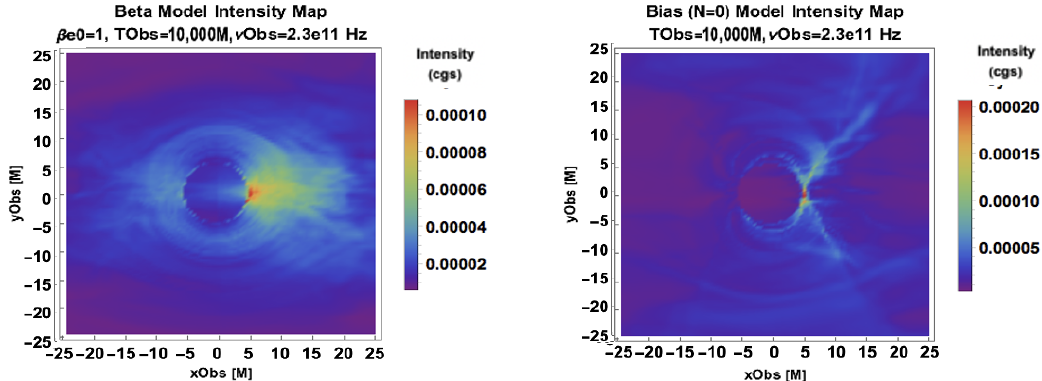
Figure 3. A parameter scan of the Constant Electron Beta Model ( Left ) with f = 0.1, ( Right ) f = 0.5, β e 0 = 0.01 ( Top ), β e 0 = 0.01 = 0.1 ( Middle ), and β e 0 = 1 ( Bottom ). Magnetic Bias Model with β e 0 = 1 and N = 0 ( Bottom Right ).